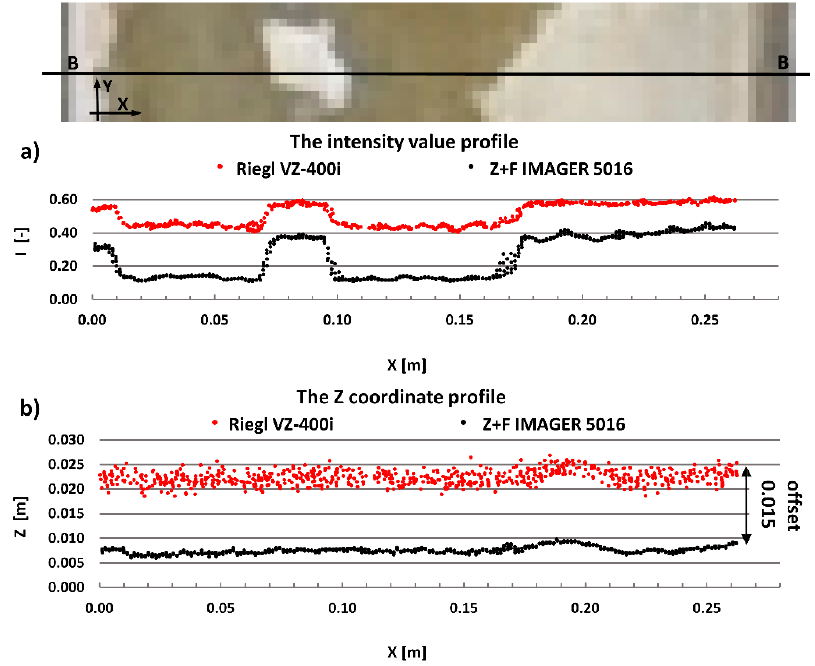
Figure 5. BB profiles—walls with patches of falling paint: ( a ) intensity data profile and ( b ) geometric data profile.